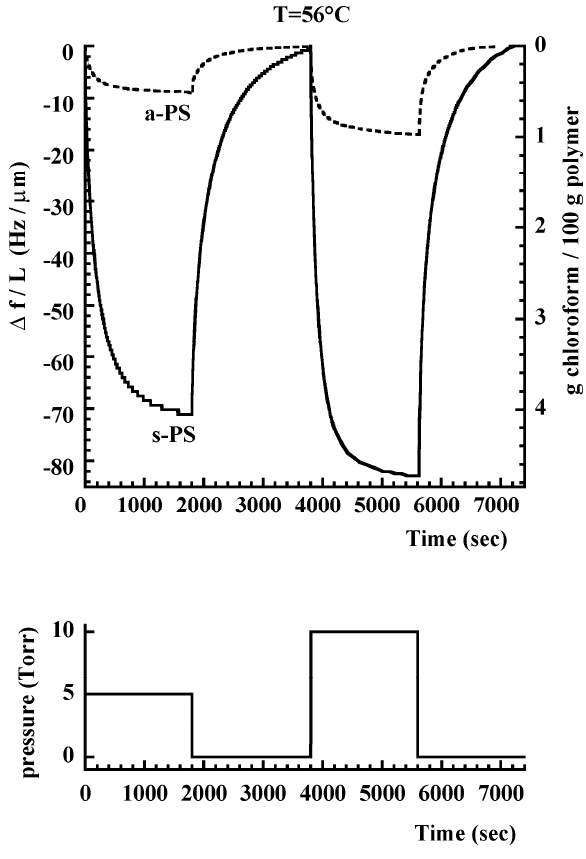
Figure 8. Comparison (upper plot) of the response of a QCM sensor coated by a amorphous a-PS film (dashed line) to square wave changes of chloroform pressure (lower plot). L represents the thickness of coating film. % b.w. increase of the film as a consequence of absorption of chloroform is also